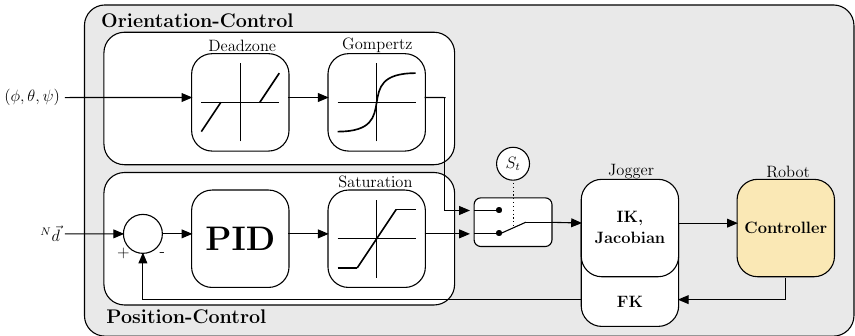
Figure 7. 6-DoF Robot control block diagram. The trigger signal S t toggles Cartesian orientation and position control. The toggle is set when an eye blink or other discrete event occurs. The Cartesian position control is generated through a closed loop PID controller with anti-windup and saturation. The error term is calculated from the desired 3D head- or eye-gaze (setpoint) and the robots EFF position from its respective forward kinematics (FK). The orientation of the EFF is mapped based on a gompertz function if the head angles exceed a certain deadzone. Either the saturated position or angle increment is fed to the jogger that calculates the inverse kinematics (IK) and Jacobian to teratively increment the robots position or orientation while the input is